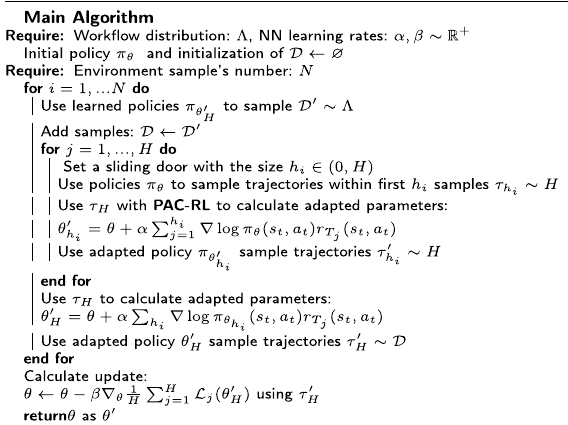
Algorithm 1 Main